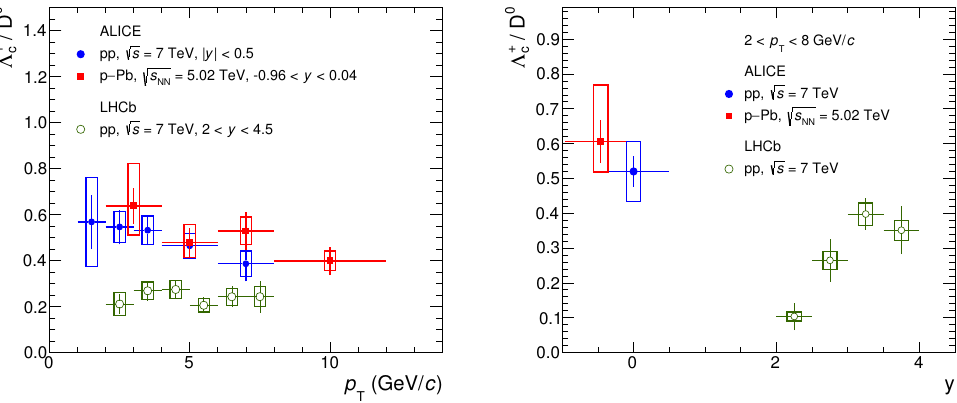
Figure 10 . The (cid:3) + /D 0 ratio measured in pp and p-Pb collisions by ALICE, compared with the c LHCb measurement [52, 97] as a function of p T (left) and as a function of y for 2 < p T < 8 GeV/ c